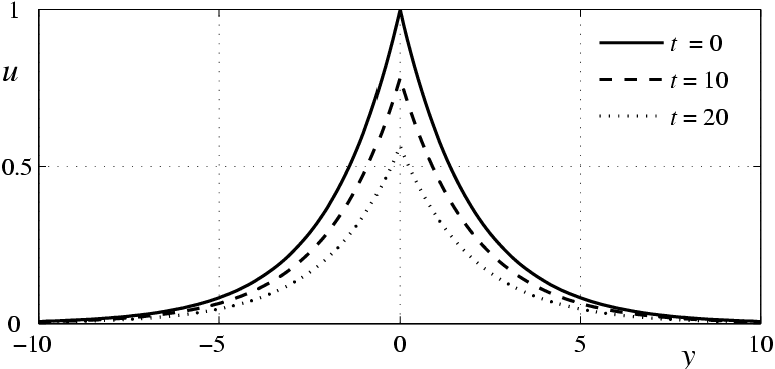
Figure 1. Evolution of the solution to the Cauchy problem (12), (13) with the initial function u 0 ( y ) = exp {− c | y |} for c = 0.5, κ = 0.25 · 10 − 3